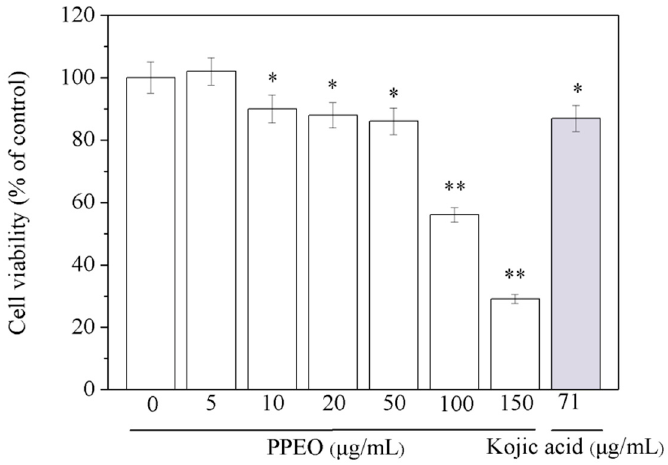
Figure 3. Effect of PPEO on B16 melanoma cell viability. * Indicates samples that are significantly different ( n = 3; * p < 0.05 and ** p < 0.01 compared with the blank control group).